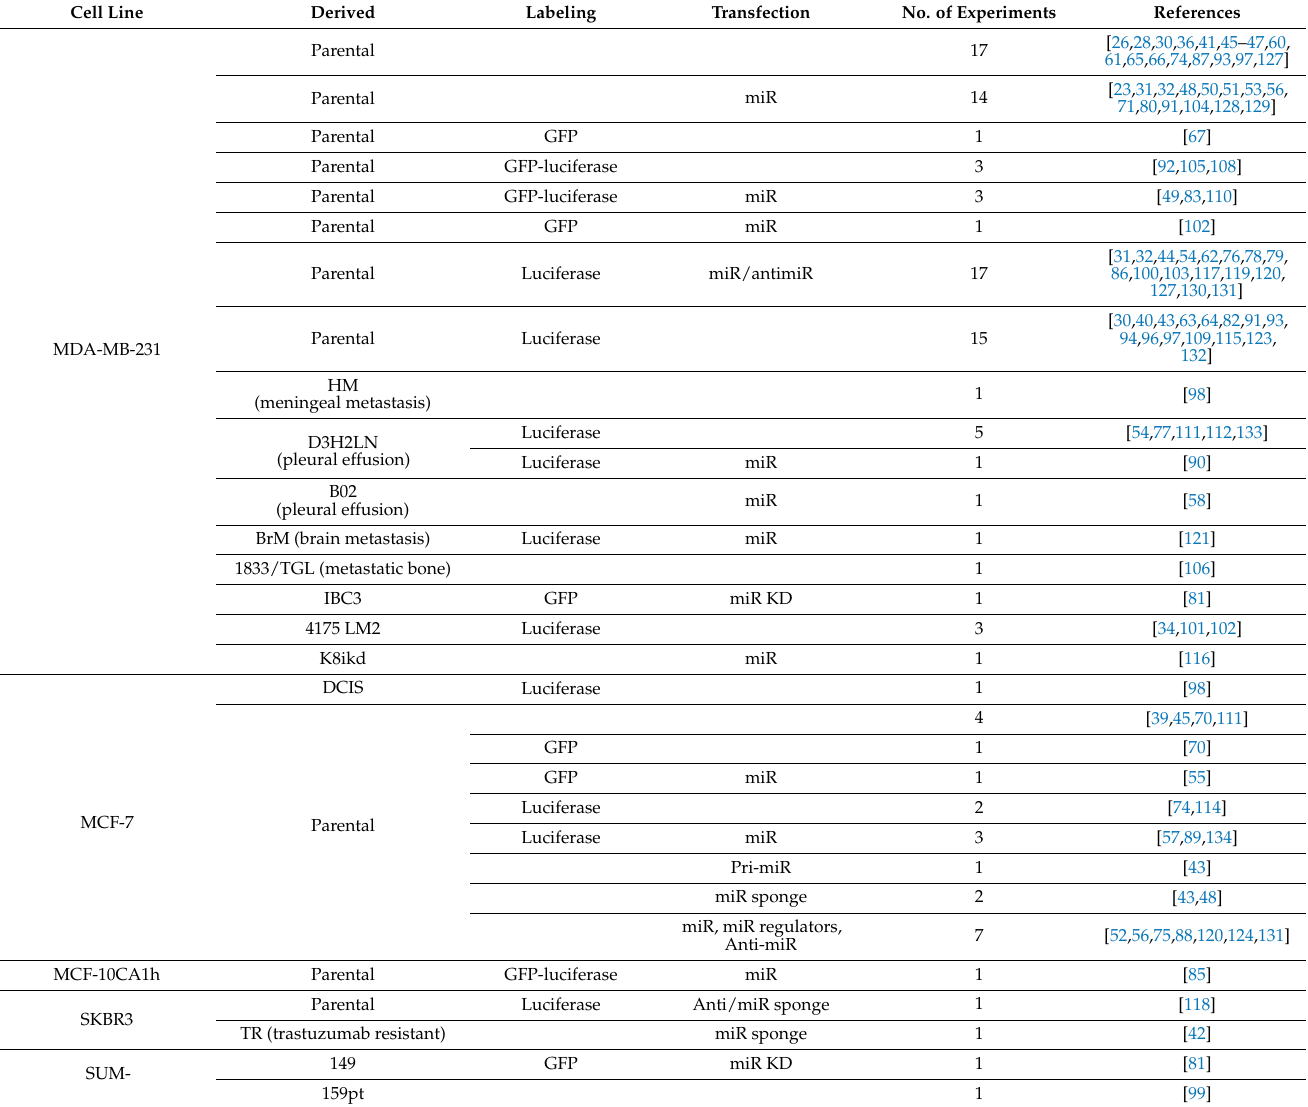
Figure 3. The absolute number of experiments regarding the cell lines, BrCSCs and PDX used to generate animal mice models. BrCSCs: breast cancer stem cells; PDX: patient-derived xenograft; and T47D-TR: tamoxifen-resistant. Table 2. Cell lines used in miRNA